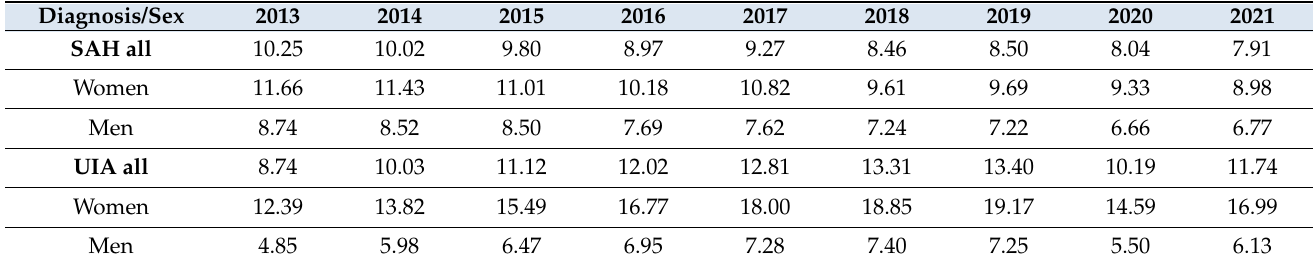
Table 2. The rate of patients with an identified diagnosis by year per 100,000